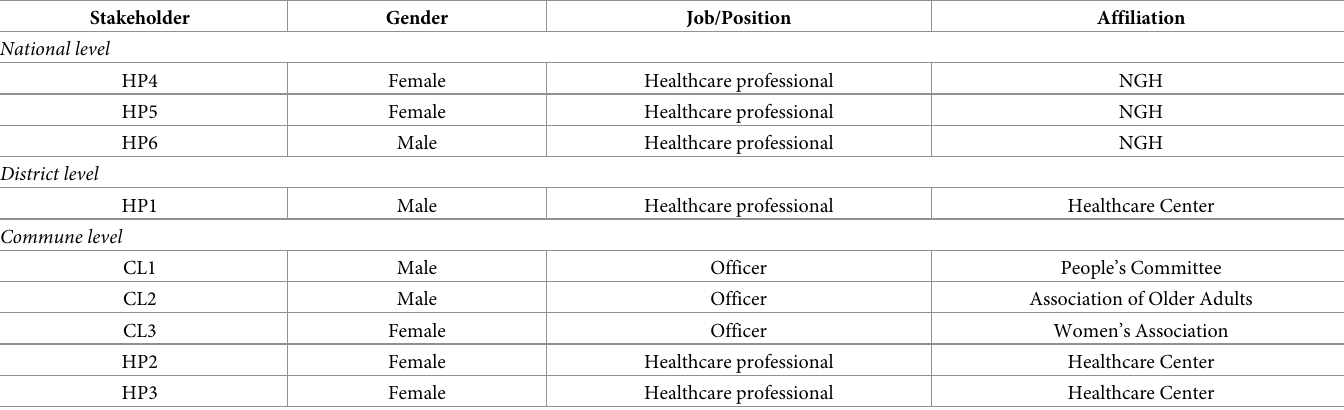
Table 2. Community leader and healthcare provider characteristics (N =